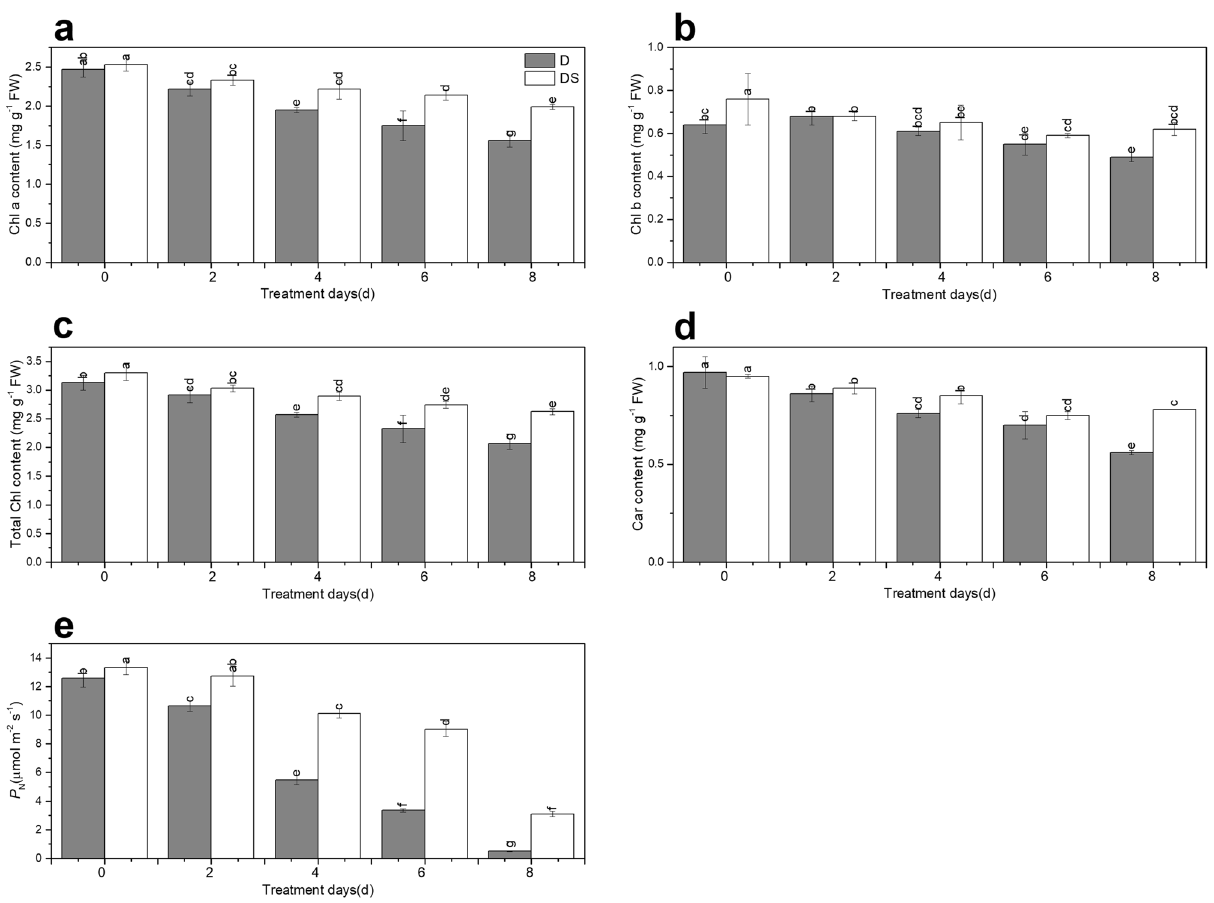
Figure 1. Uniconazole-induced chlorophyll content ( a – d ) and net photosynthetic rate ( e ) under drought stress. All data are presented as the means ± standard errors (n = 4). D and DS expressed as treatments under drought stress and drought stress + uniconazole,